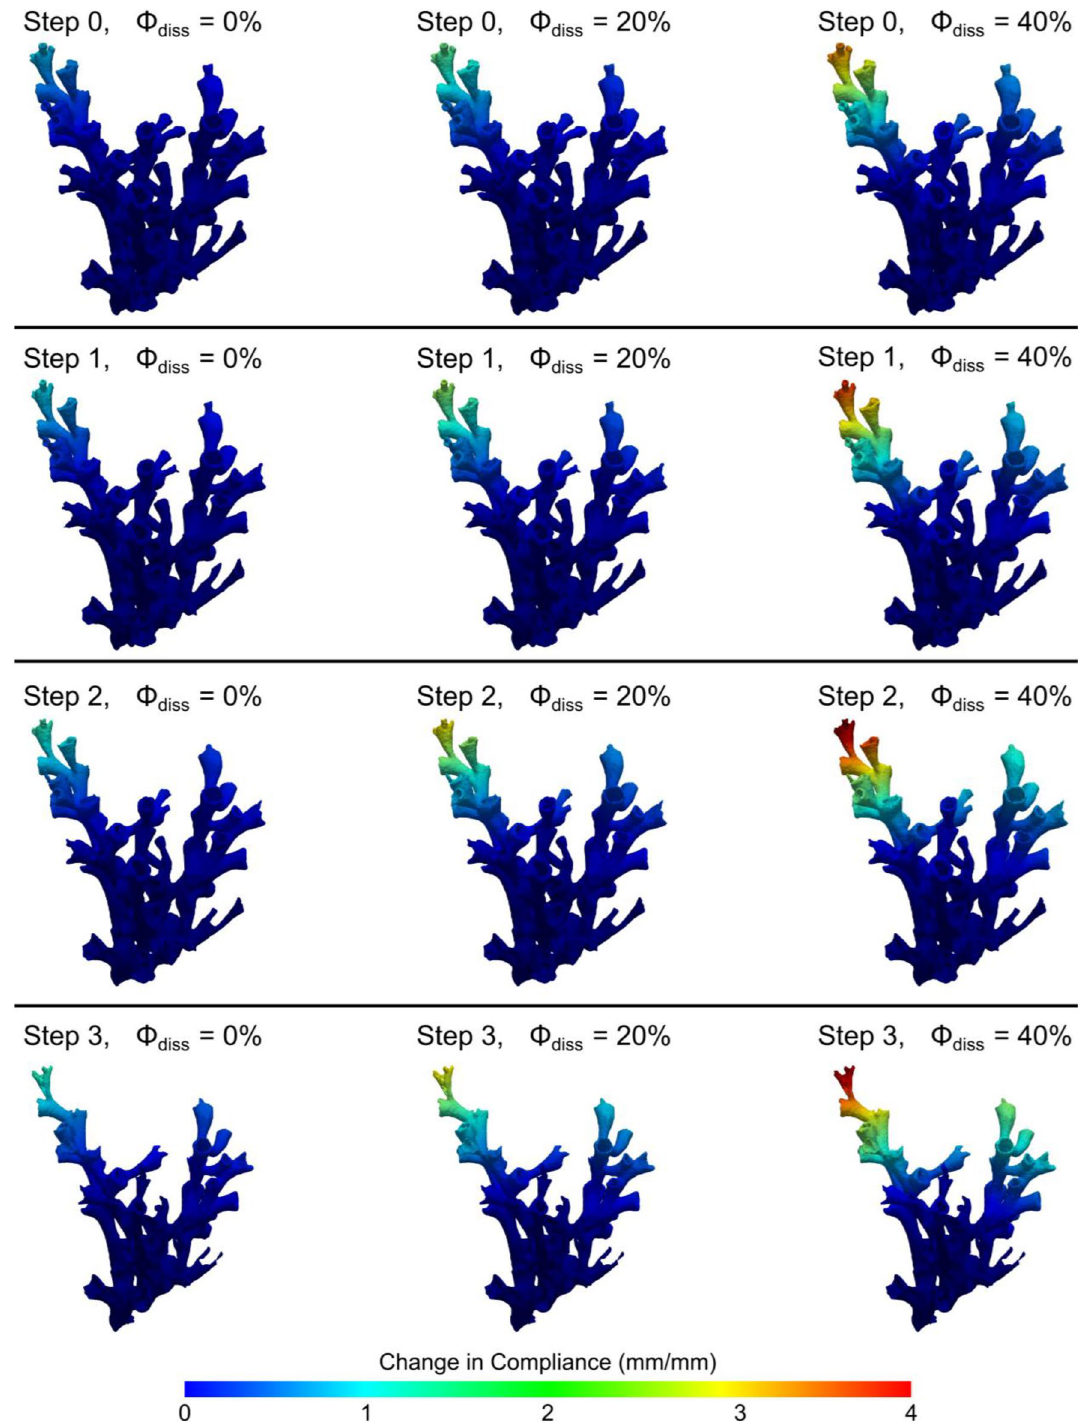
Figure 8. Strength loss of an exemplary L. pertusa colony: An increase in skeletal porosity (left to right) and an additional reduction in wall thickness (top to bottom) leads to decreasing load bearing capacity with the combination of both effects (bottom right) yielding a fourfold increase in flexibility resulting in a significantly increased fragility. For illustration purposes, we use deflection normalised on the top left case. The weaker the skeleton becomes the further peripheral elements can be deflected. Consequently, the highest internal loading is found towards the encastred base of the